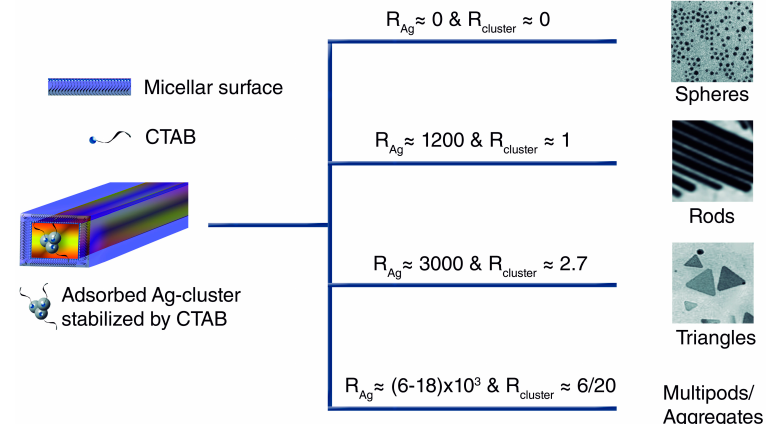
Figure 11. Structure directing of Au nanostructure catalysis by Ag clusters (the Figure is from